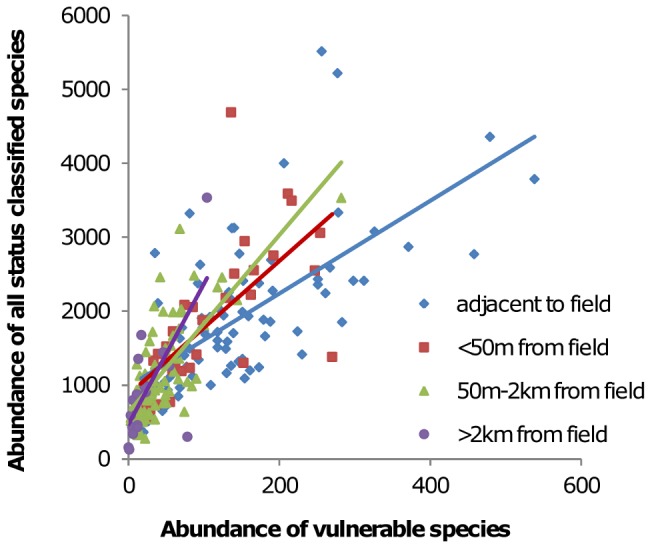
Example relationship between the abundance of all status classified species (sum of increasing, decreasing, and vulnerable) and the abundance of vulnerable species.There was a strong overall positive relationship. However, plotting and fitting linear regression lines to sites of differing distance to field showed a distinct difference in the abundance of vulnerable species. At sites >2 km away from fields (sites in towns and cities) there was a lower proportion of vulnerable species than at sites adjacent to fields (rural sites).